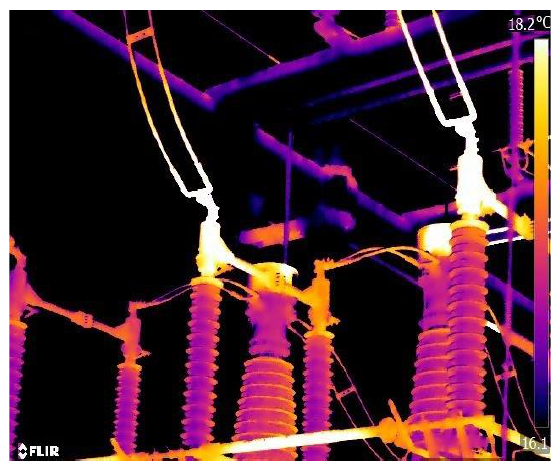
Figure 5. Infrared thermal image of cutout switch fuse connection.